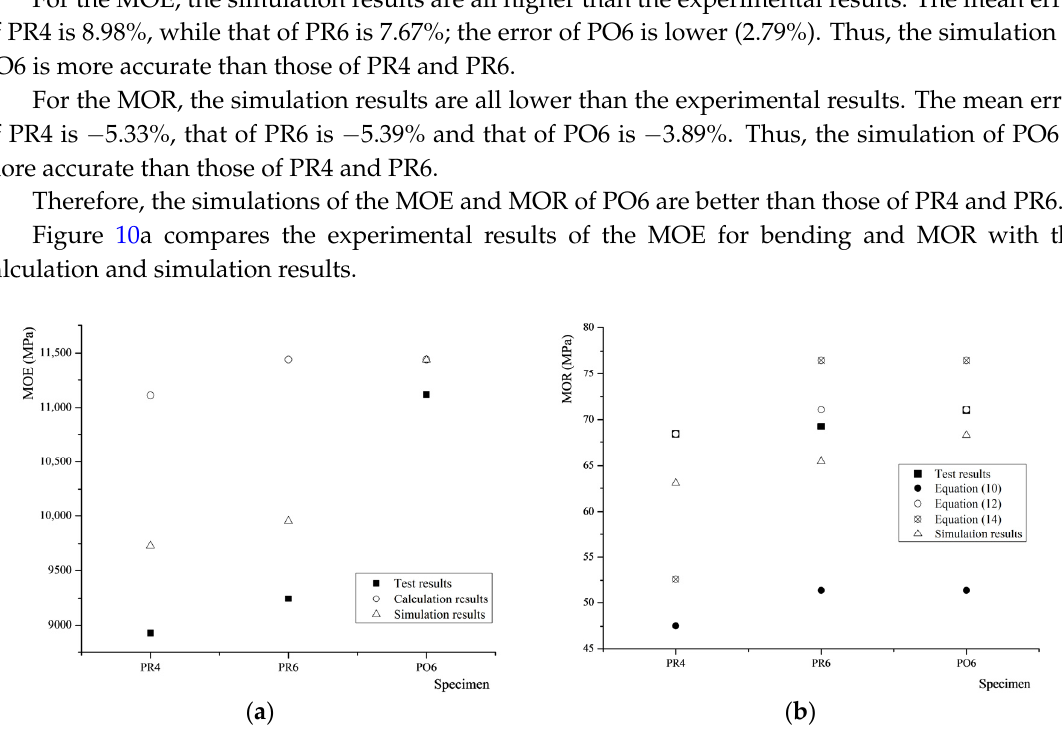
Figure 10. Experimental results of MOE ( a ) and MOR ( b ) compared to the calculation and simulation results.